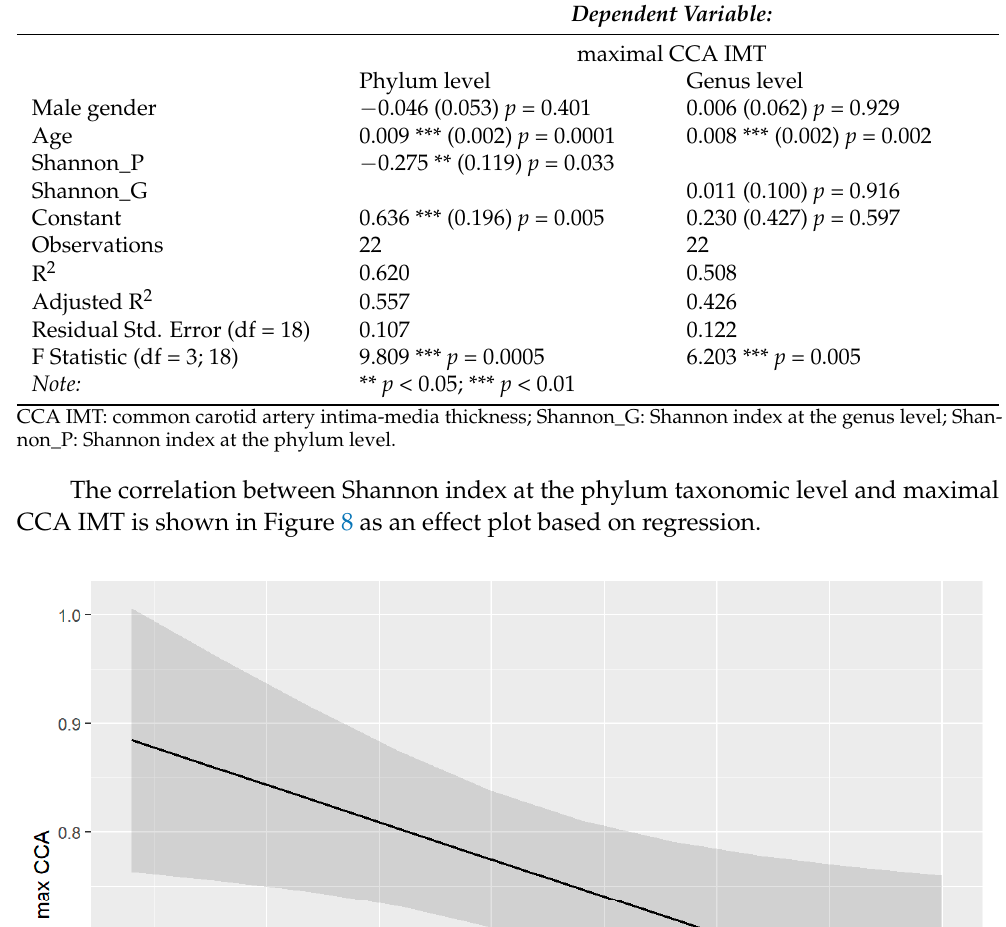
Figure 9. The results of PCA at the phylum level. Green: OSA − atherosclerosis. Red: OSA + atherosclerosis.